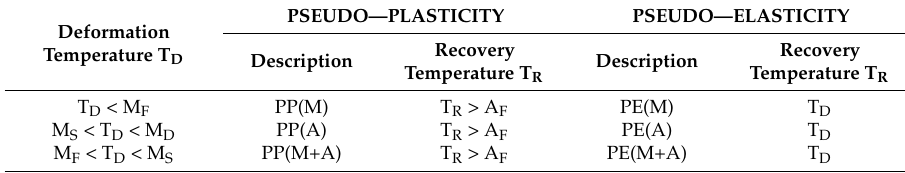
Table 2. Proposed nomenclature for PP (pseudo-plastic) and PE (pseudo-elastic) shape memory